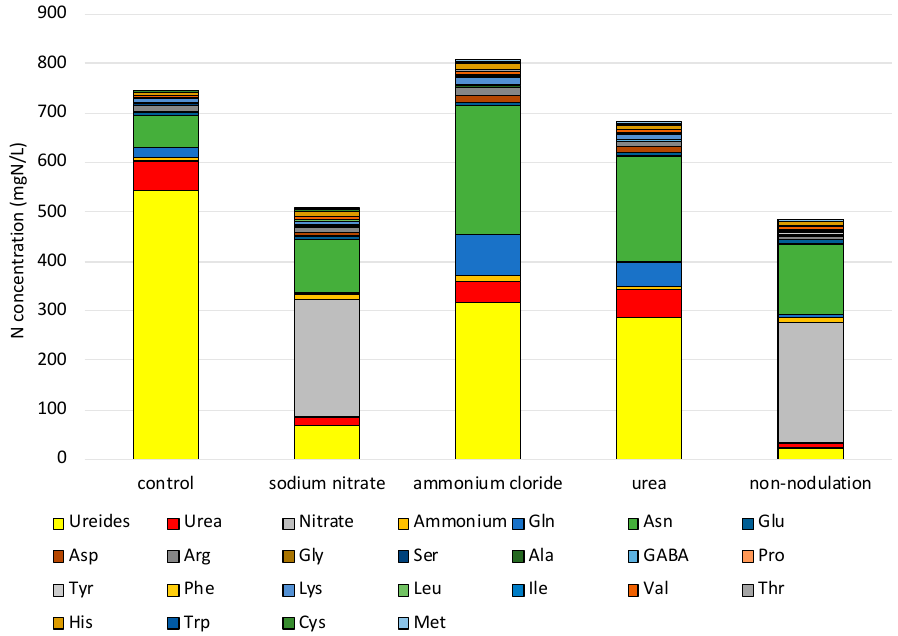
Figure 9. Nitrogen concentrations of N compounds in xylem sap of soybean.